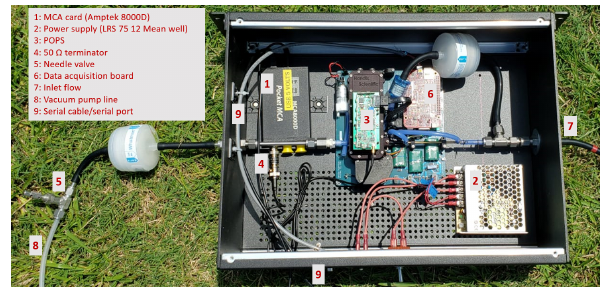
Figure 2. Photograph of the modified